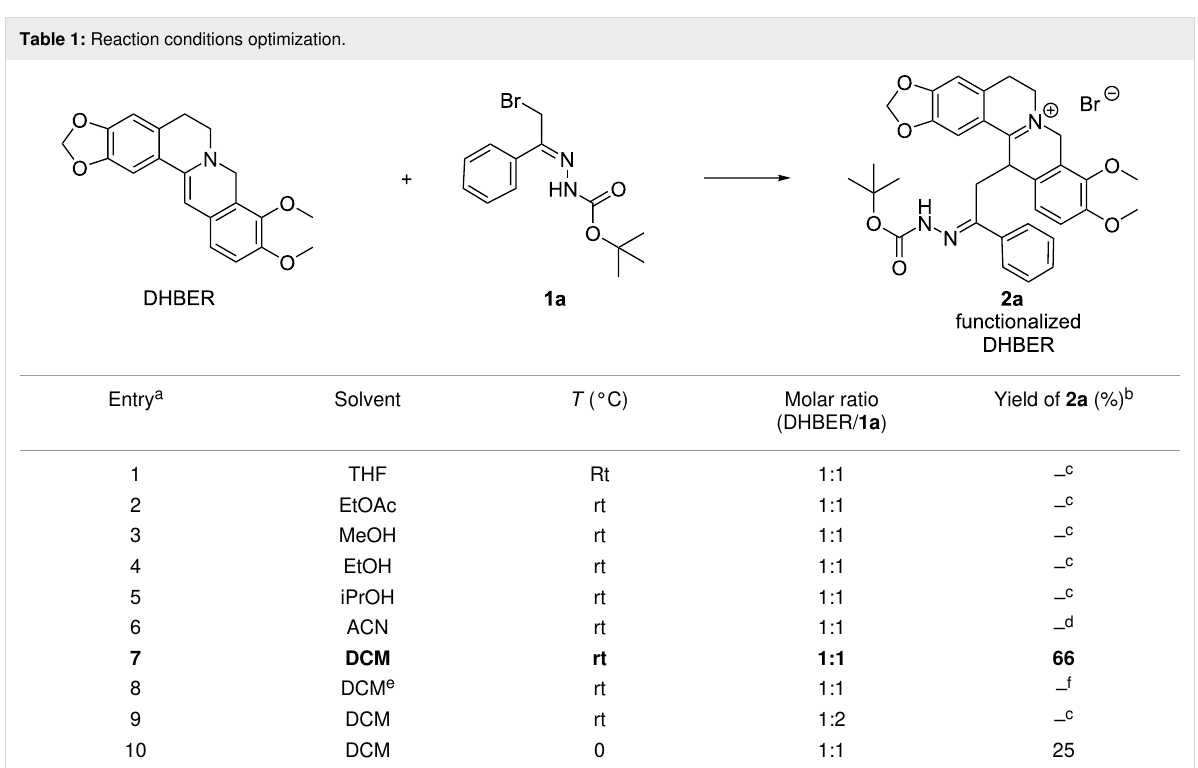
Table 1: Reaction conditions